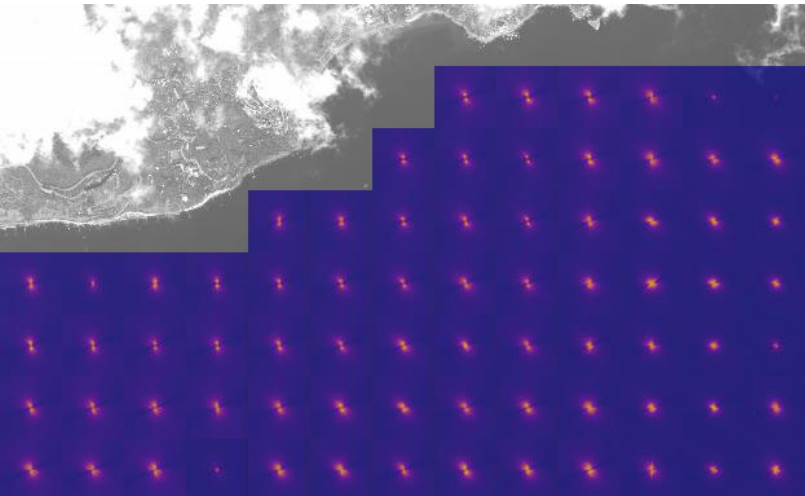
Figure 4. Panorama of the slope spectra. Slope spectra retrieved from 1024 × 1024 pixel (410 × 410 m) fragments are shown at the locations of the original satellite image fragments.